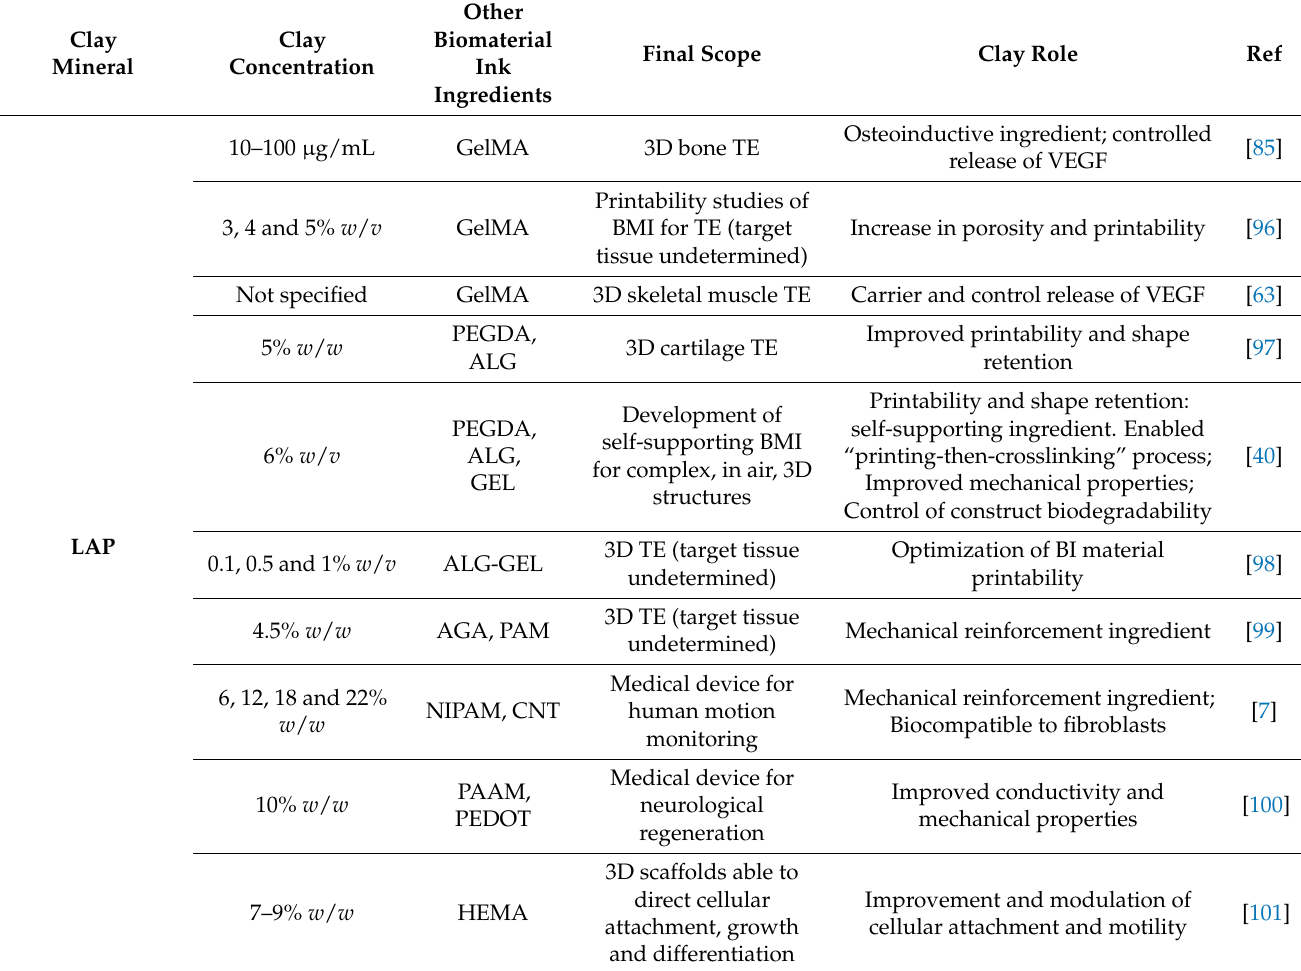
Table 3. Biomaterial inks include clay minerals as part of their formula: clay type and concentration, final scope and main function(s) of the mineral within the BMI.